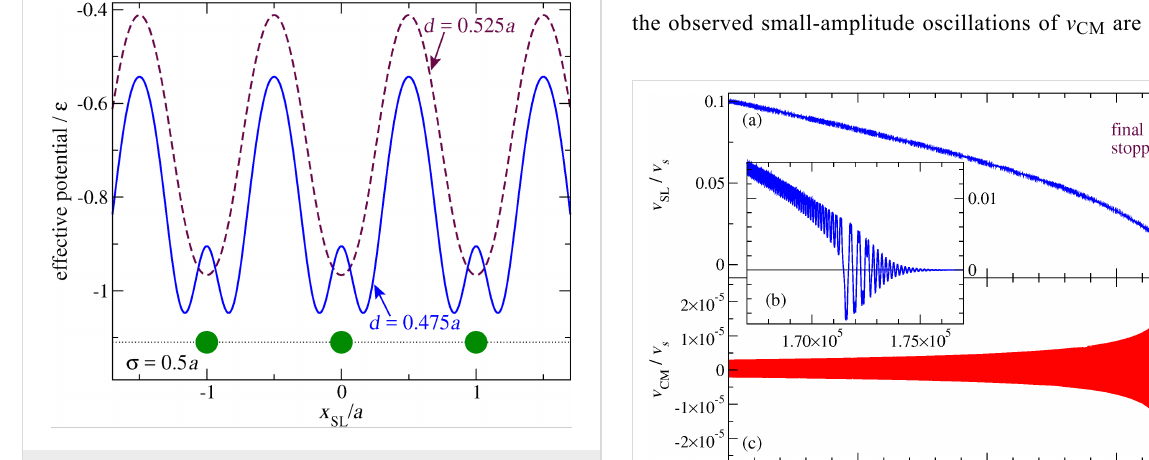
Figure 2: The potential-energy profile experienced by the slider as it moves along a hypothetical chain with atoms frozen at positions x j = ja (big circles), for a LJ parameter σ = 0.5 a . Dashed curve: as obtained with d = 0.525 a > σ ; solid curve: with d = 0.475 a < σ , the value adopted for the rest of this work.